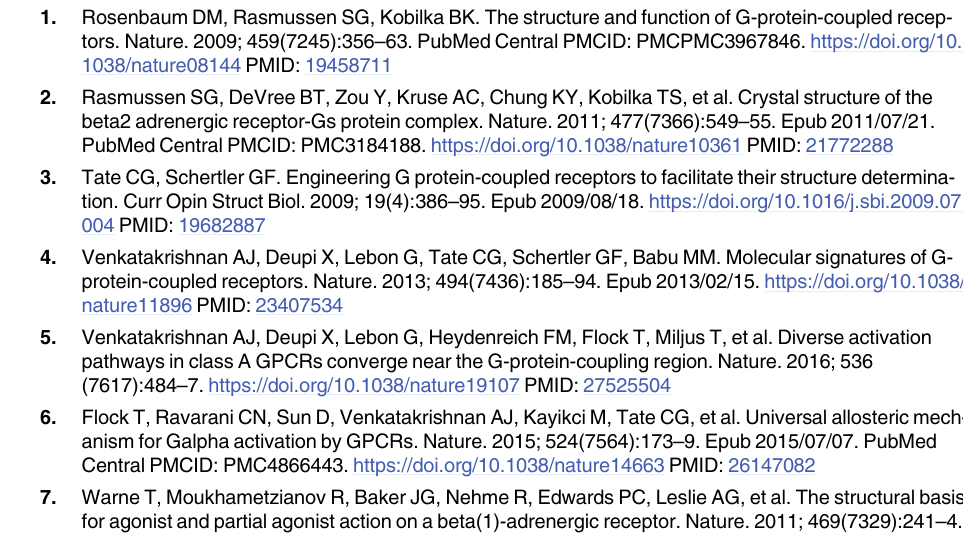
S7 Fig. Stability of the purified donitriptan-bound 5HT complex was assembled from purified components and analysed by SEC immediately after assembly (blue line) or after the sample was stored at 4˚C for 48h (red line). Fractions (0.5 ml) were collected and analysed by SDS-PAGE: (b) immediately after assembly; (c) after 48 h at